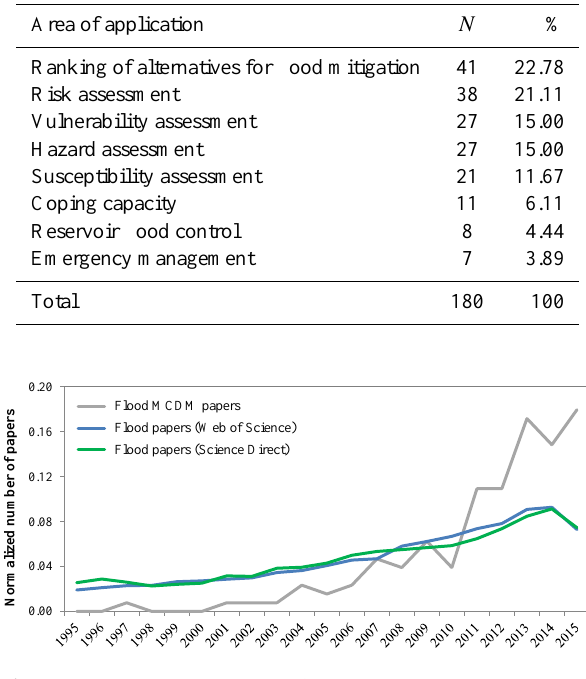
Figure 2. Normalized number of MCDM and flood papers pub- lished between 1995–June 2015, based on data from the Web of Science and Science Direct.